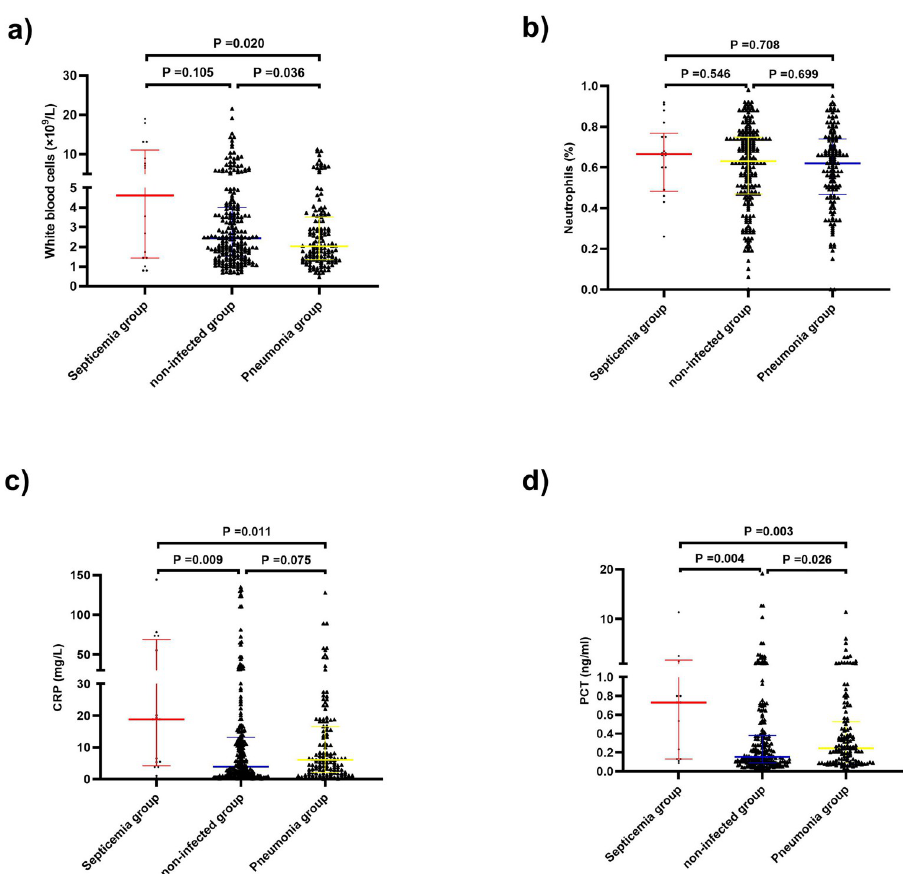
Fig 5. Analysis of inflammatory parameters of patients with severe fever with thrombocytopenia syndrome. (A) White blood cell (WBC); (B) N%; (C) C-reactive protein (CRP); (D) Procalcitonin (PCT) levels in all patients with SFTS (N =